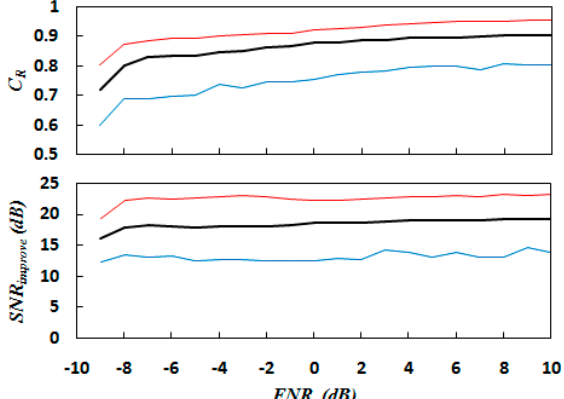
Figure 7. Correlation coe ffi cient and signal–noise ratio (SNR) improvement results against the FECG to noise energy ratio ( FNR ) using the proposed method for 105 synthetic signals. The red, blue, and black lines present the maximum, minimum, and average values,